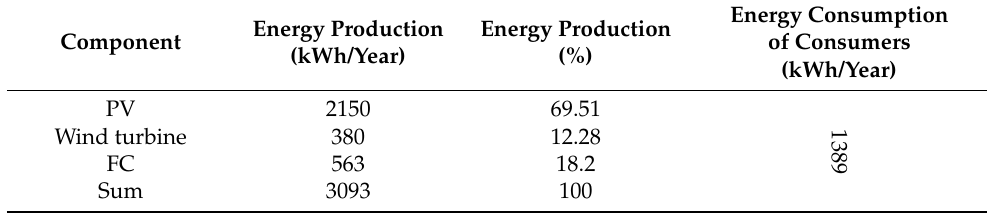
Table 11. The annual production for the second case using iHOGA simulator.